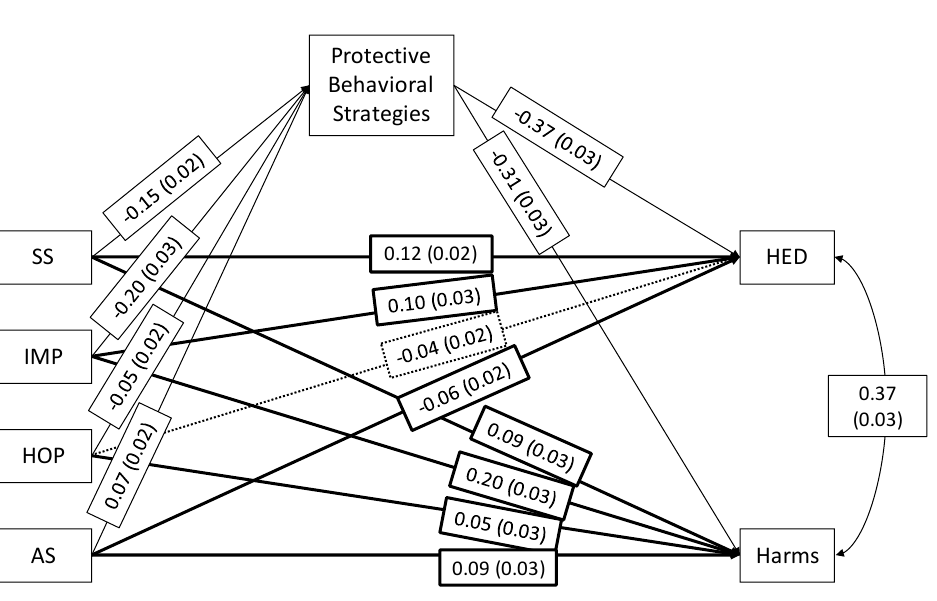
Figure 2. Standardized coefficients for the Study 2 mediational model (a, b, and c’ paths) from Substance Use Risk Profile Scale (SURPS) [4] personality traits to heavy episodic drinking (HED) and alcohol-related harms (Harms) through protective behavioral strategy (PBS) use. SS = SURPS Sensation Seeking; IMP = SURPS Impulsivity; HOP = SURPS Hopelessness; AS = SURPS Anxiety Sensitivity. Light lines represent indirect effects through PBS use and heavy lines represent direct effects. Solid lines represent significant paths; dashed lines indicate non-significant paths, p < 0.01.